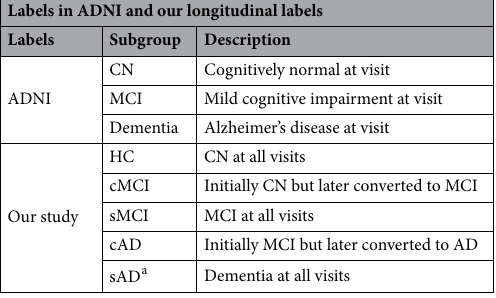
Table 1. The original ADNI labels and the longitudinal labels used in the present study. was not included in the present study as we focused on converters.